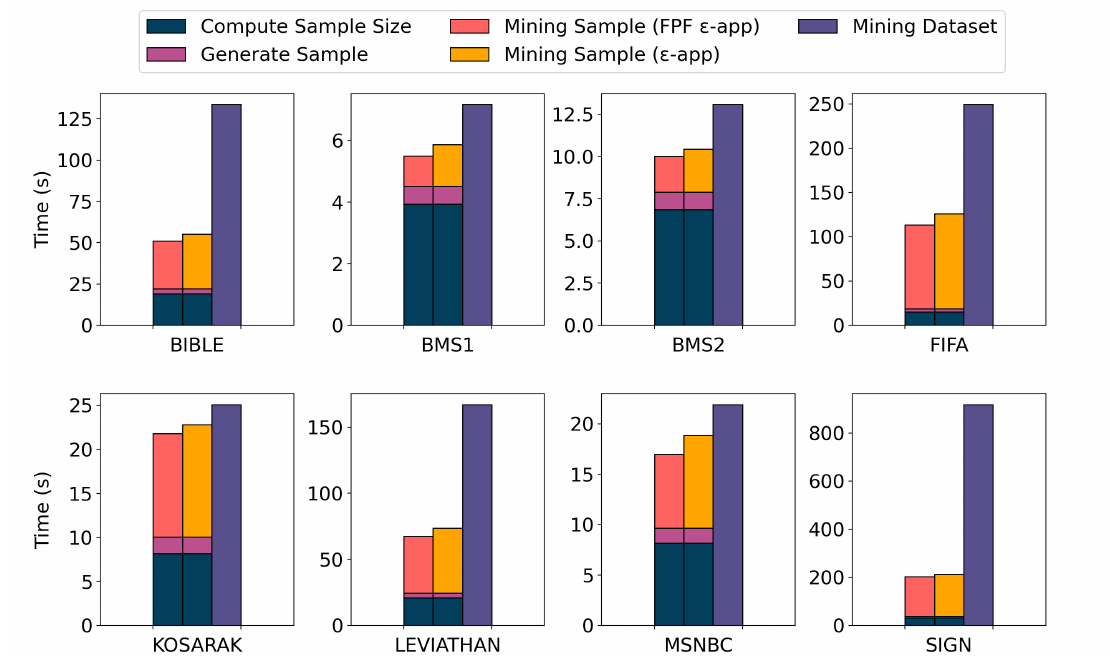
Figure 3. Execution time of the sampling algorithm. The execution time required to mine the whole dataset, and the execution times of the sampling algorithm to obtain an ε -approximation and a false positives free (FPF) ε -approximation are reported. For the sampling algorithms, we show the execution time to compute the sample size, the execution time to generate the sample, and the execution time to mine the